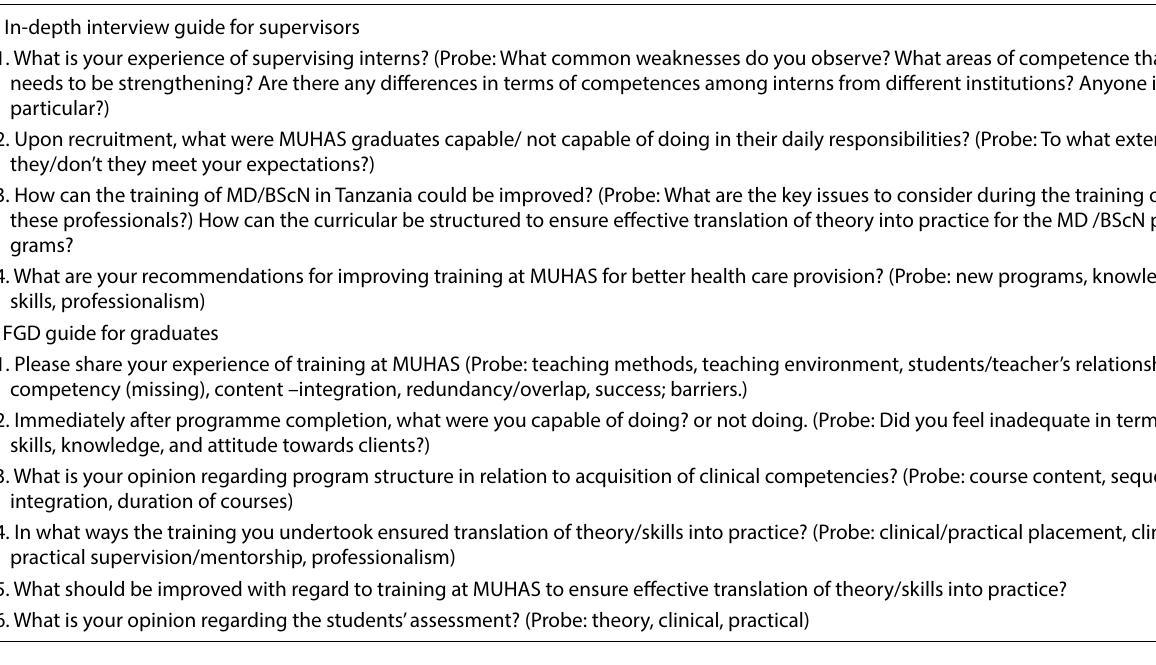
Table 2 The In-depth Interview and Focus Group Discussion